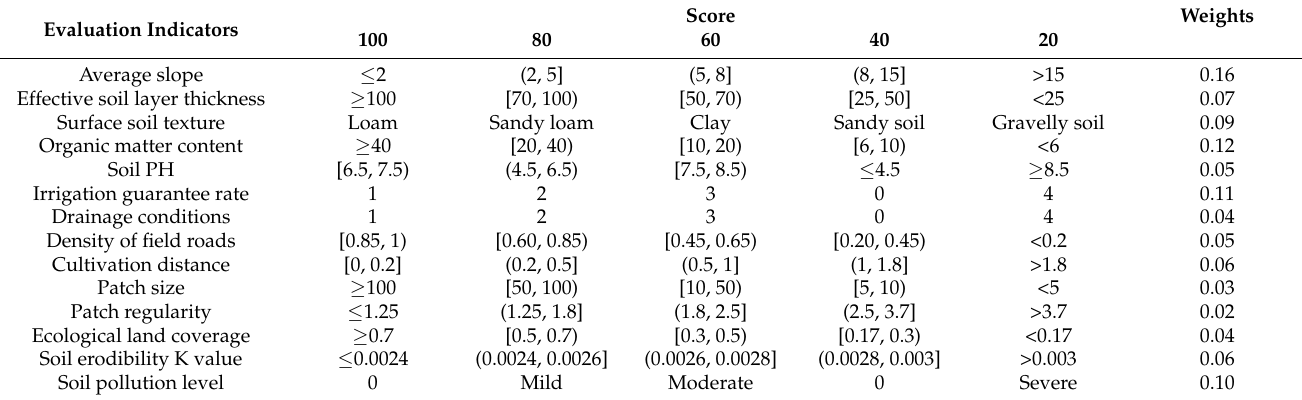
Table 2. Criteria and weights of quality evaluation indicators for cultivated land in Long’an